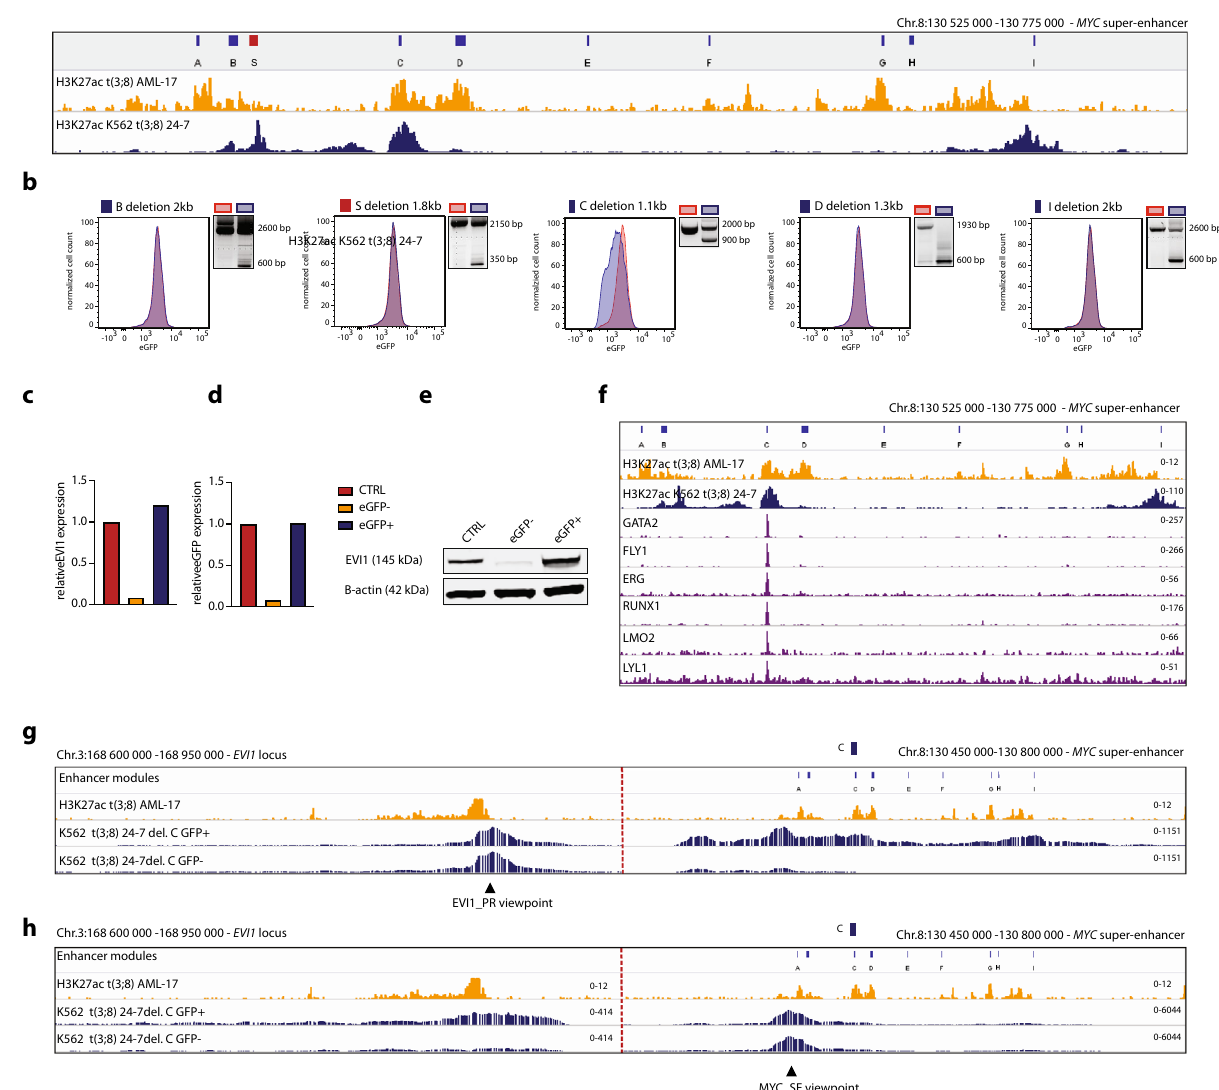
Fig. 4 One critical enhancer module in the MYC SE drives EVI1 transcription. a Overview of the MYC super-enhancer, with previously characterized individual enhancer modules A-I 28 and added module S based on high H3K27ac signal at this location in all K562 EVI1-eGFP t(3;8) clones. Underneath, H3K27ac of a primary t(3;8) AML (AML-17, orange) and of K562 t(3;8) EVI1-eGFP clone 24-7 (blue). b Flow cytometry plots (clone 24-7) shown for each indicated enhancer module deletion. In red are the control cells (no Cas9) and in blue are the cells carrying the deletion. On the right of each graph, the successful deletion of each element is shown by PCR. Source data are provided as a Source Data fi le. c EVI1 expression relative to PBGD by qPCR in eGFP − and eGFP + sorted cell fractions after deletion of enhancer module C. The bars represent only one data point, from the same experiment as the fl ow cytometry data shown in panel b . d eGFP expression relative to PBGD by qPCR in eGFP − and eGFP + sorted cell fractions after deletion of enhancer module C. The bars represent only one data point, from the same experiment as the fl ow cytometry data shown in panel b . e EVI1 protein levels by Western blotting in eGFP − and eGFP + sorted fractions after deletion of enhancer module C. Source data are provided as a Source Data fi le. f MYC SE element C recruits a set of HSPC-active transcription factors shown by ChIP-seq data of CD34 + cells (purple tracks 29 ), H3K27ac of primary t(3;8) AML (AML-17, orange), and of a K562 t(3;8) (clone 24-7, dark blue) to illustrate enhancer modules. g Chromatin interaction shown by 4C-seq data, using the EVI1 promoter as the viewpoint (triangle symbol). The EVI1 promoter and the − 1.7 Mb MYC SE are shown on the left and right sections, respectively, separated by a dotted red line. The upper orange panel shows H3K27ac ChIP-seq of a t(3;8) primary AML (AML-17). In blue, 4C-seq tracks of K562 EVI1-eGFP t(3;8) clone 24-7 cells in which the enhancer module C was deleted. In the upper blue track, eGFP + sorted cells, and in the lower blue track, eGFP − cells. h Same as g , but using the MYC super-enhancer as a viewpoint (triangle